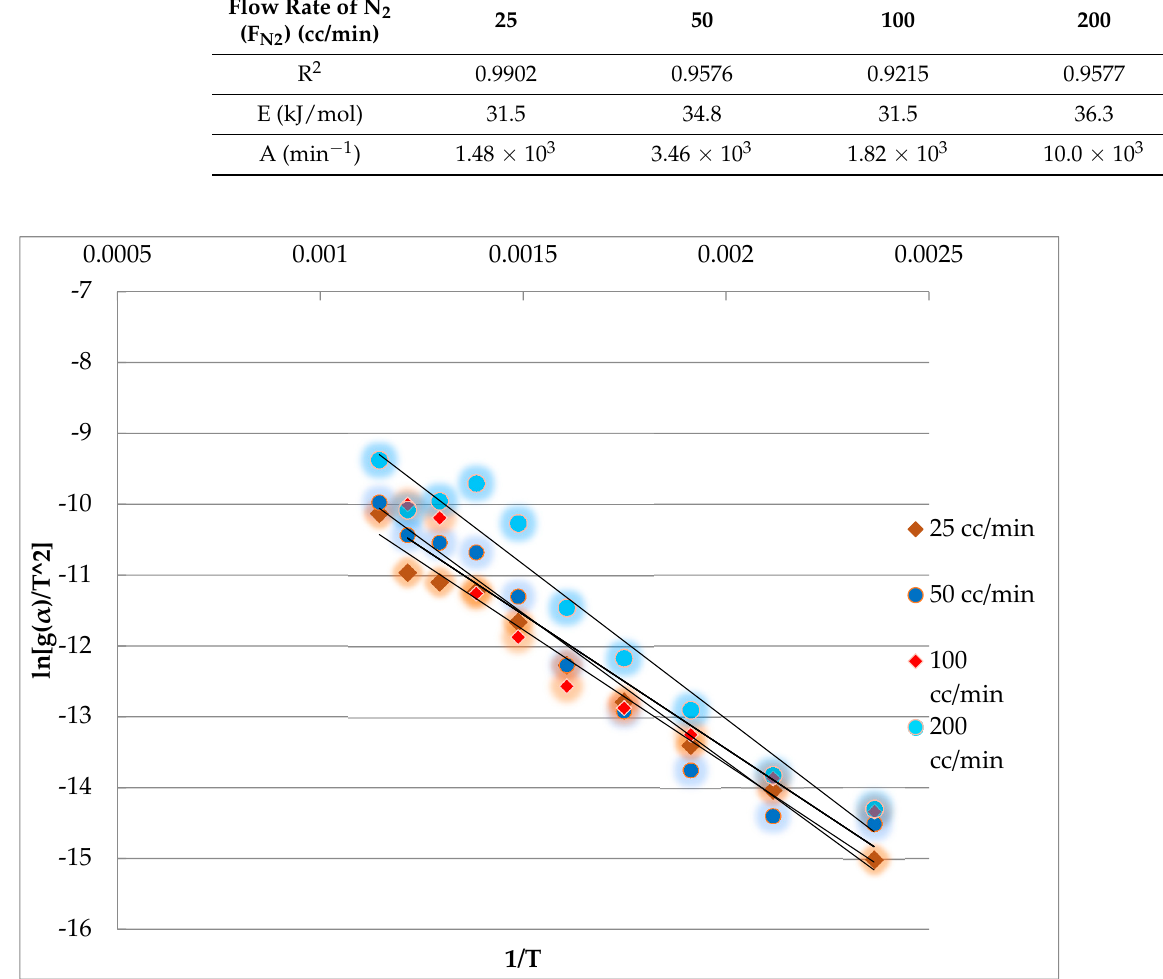
Figure 3. Effect of carrier gas flow rate on the kinetic parameters.